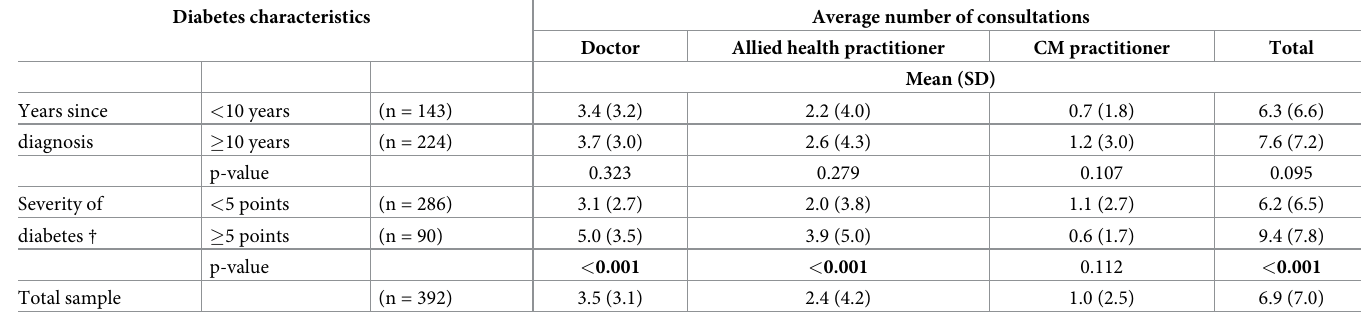
Table 1. Consultations with health care practitioners by years since diagnosis of diabetes and severity of diabetes over the past 12 months. Diabetes characteristics